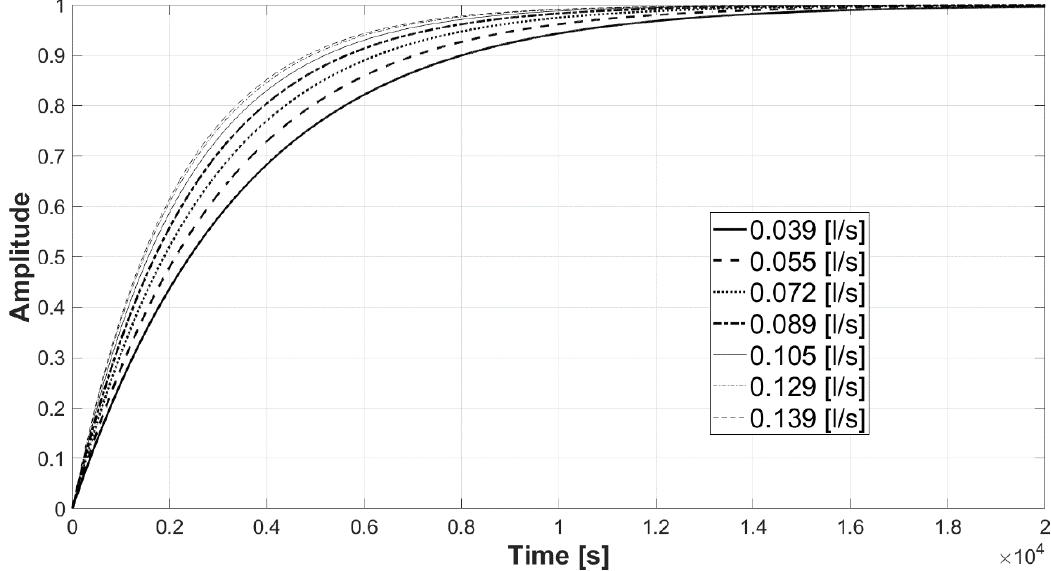
Figure 16. Step responses of the water in the storage tank at pump output between 0.039 [l/s] and 0.139 [l/s].